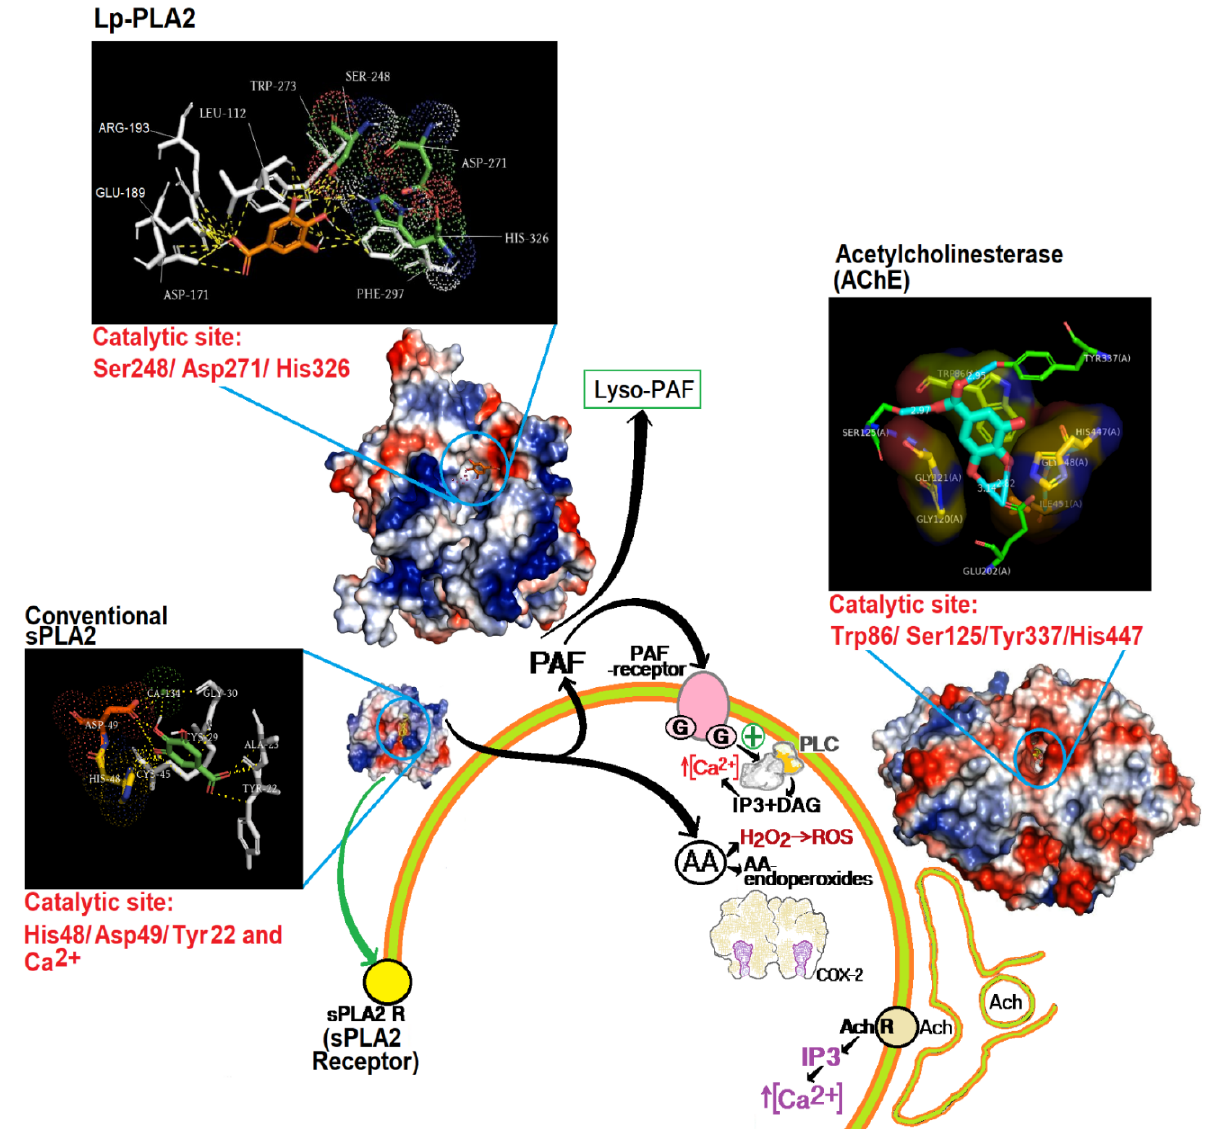
Figure 3. Possible actions of GA that led to increased levels of PAF and AA. The compound interacts with sPLA2 at the active site, binding with essential amino acid residues located in the N-terminal region (F5) and with Histidine (H48) and Aspartic acid (D49). The compound was able to bind with the catalytic site of PLA2 associated with lipoprotein (PAF Acetylhidrolase extracellular), including Ser248 and His 326 and Ser 125 and Tyr337 of the catalytic site of